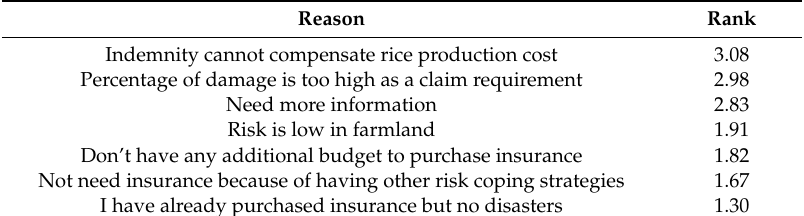
Table 4. Reasons for not willing to join in agricultural production cost